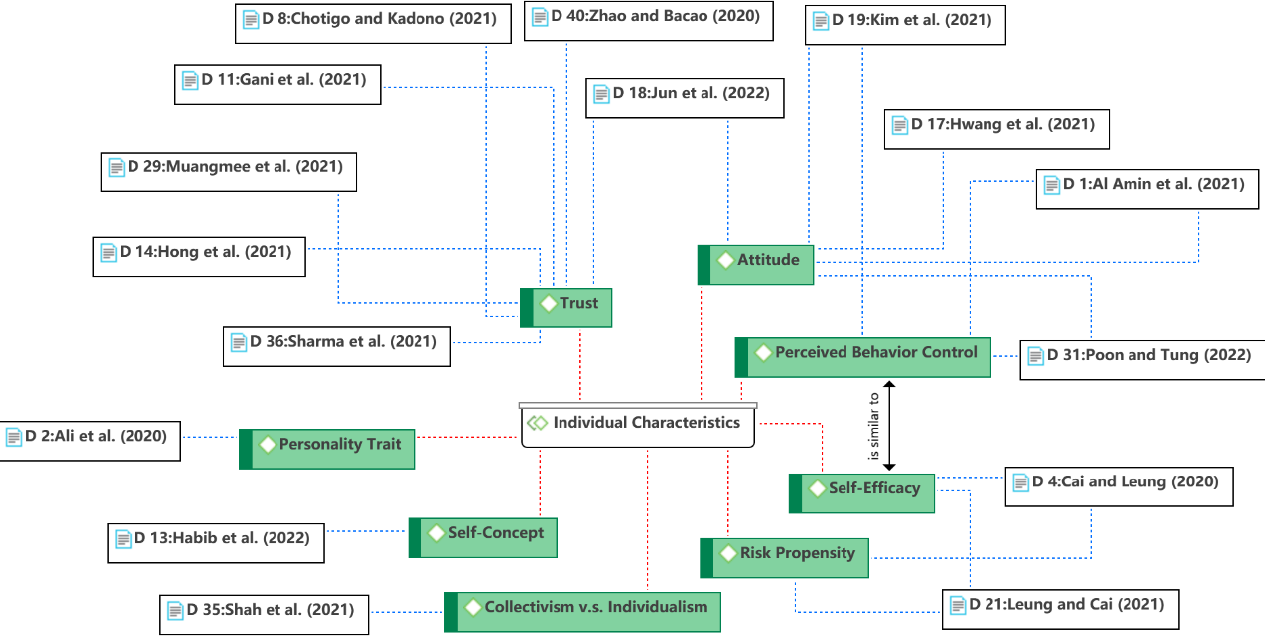
Figure 7. Theme 3: emotional and hedonic factors [7,28,37,42,44,51,52,55,58].